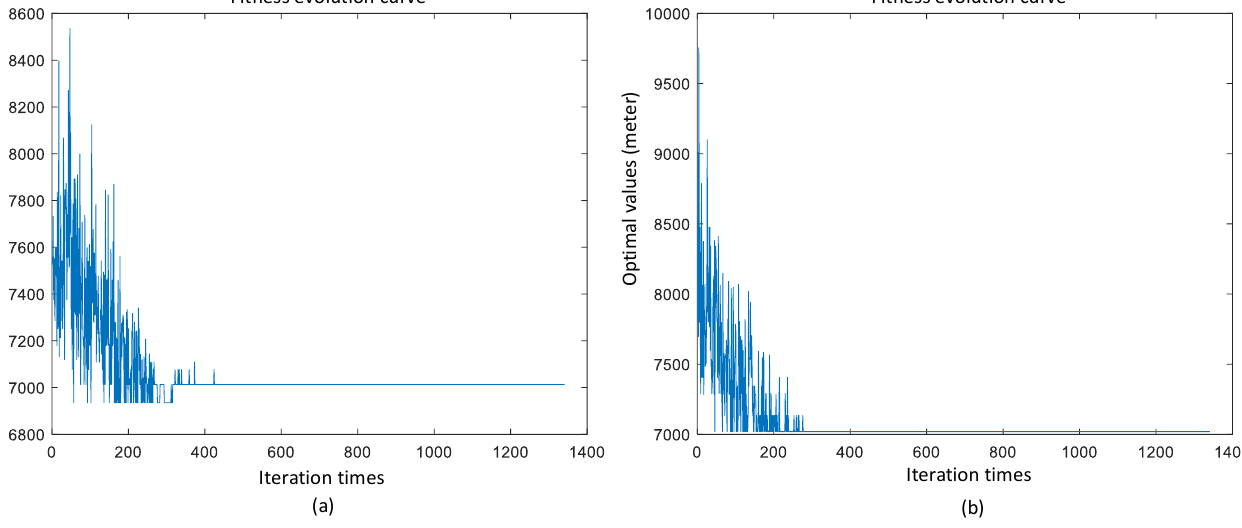
Figure 9. The fitness evolution curve of optimizations. ( a ) The maintenance value of turbines 10, 11, 8, 5, 1, 15, and 14 is 7013.1848. ( b ) The maintenance value of turbines 12, 9, 5, 8, 3, 4, and 7 is 7019.3644. Table 8. The maintenance optimization based on the improved SA algorithm.